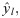
Simulation of Low-field k-Space Data.High-field k-space data yh and pure noise nh are first acquired and served as input. yh is then scaled by a2 and f to account for signal magnitude change and different relaxation behaviors at different field strengths. f can be determined based on steady state signal equations for different types of sequences (see Appendix for details). To simulate low-field data y^l, additional noise n^add, as calculated in the text, is added to compensate for the different noise levels.